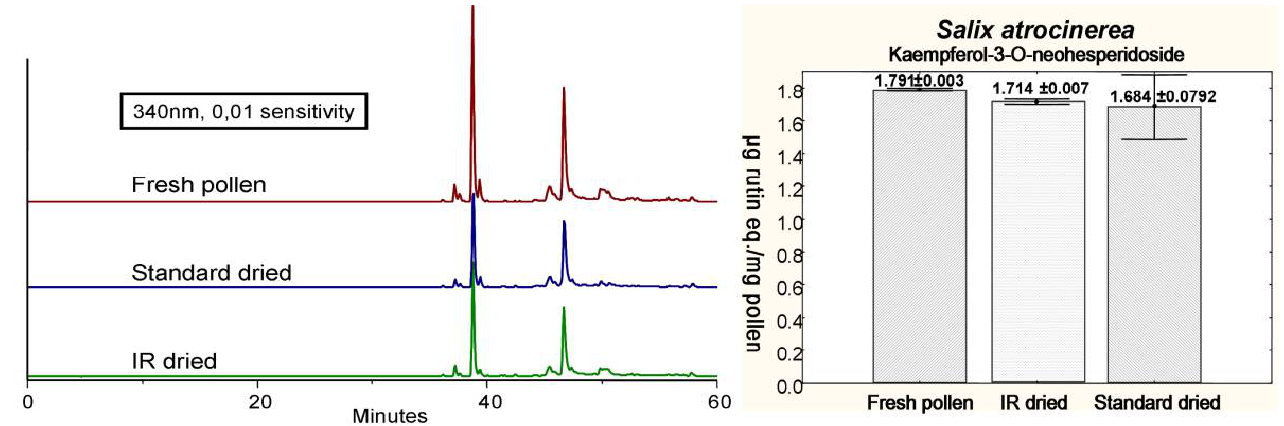
Figure 5. Chromatogram of S. atrocinerea fresh and dried pollen extract and kaempferol-3- O -neohesperidoside quantification, expressed as rutin equivalent mg/g dry pollen. Results are expressed as means ± SD (n = 3).